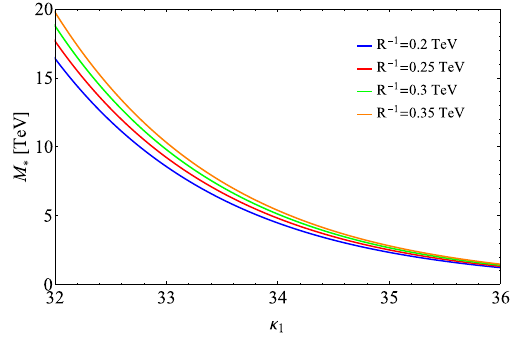
Fig. 1 The dependence of the five dimensional Planck scale M ∗ in the parameter κ 1 forvariousvaluesoftheinversesizeoftheextradimension